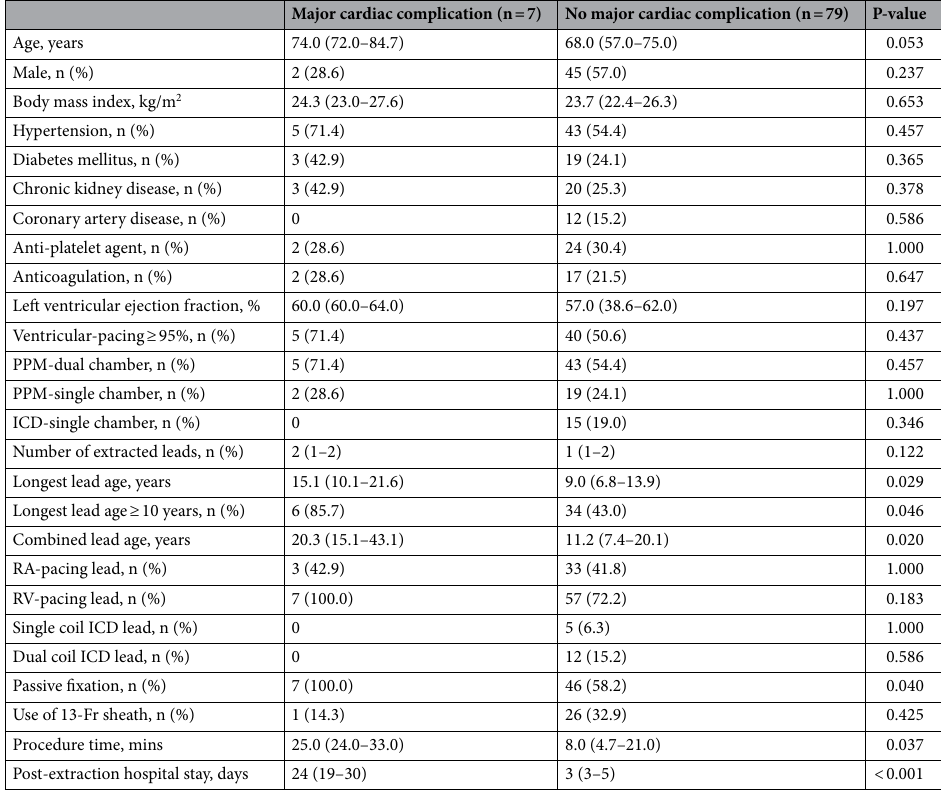
Table 3. Comparison between patients with and without major cardiac complications. Abbreviations: Fr, French; ICD, implantable cardioverter-defibrillator; PPM, permanent pacemaker; RA, right atrial; RV, right ventricular.